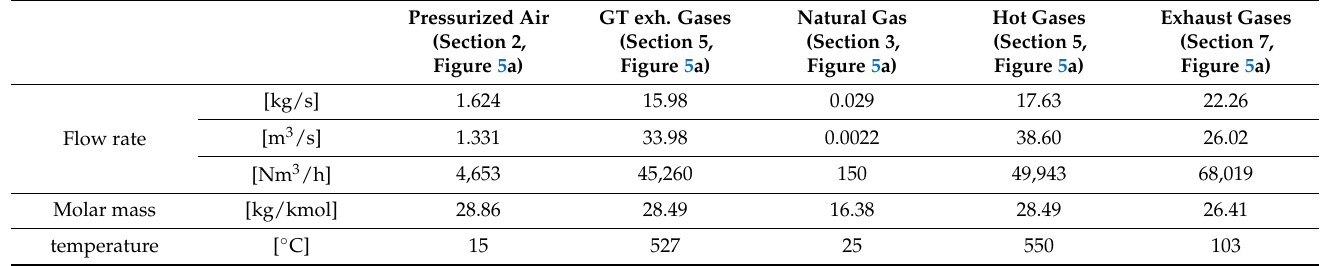
Table 7. Main results of gaseous streams for ATM 110 thermally integrated with GT